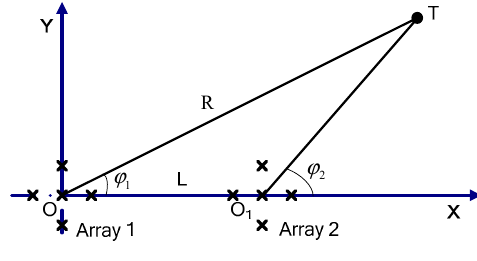
Figure 4. Model of double array.